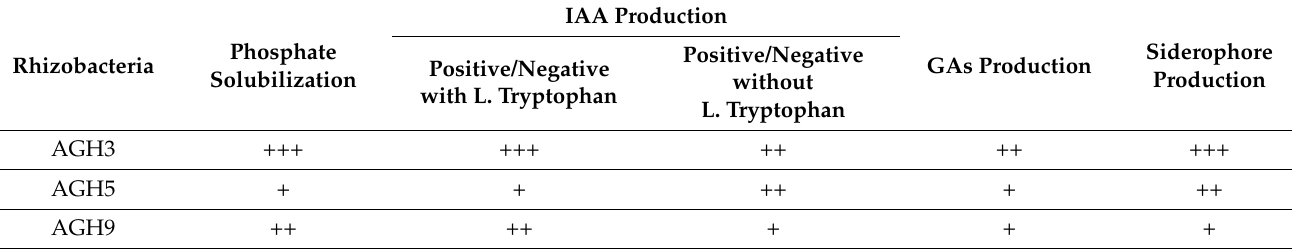
Table 2. Multi-trait PGP characteristics of AGH3, AGH5, and AGH9.